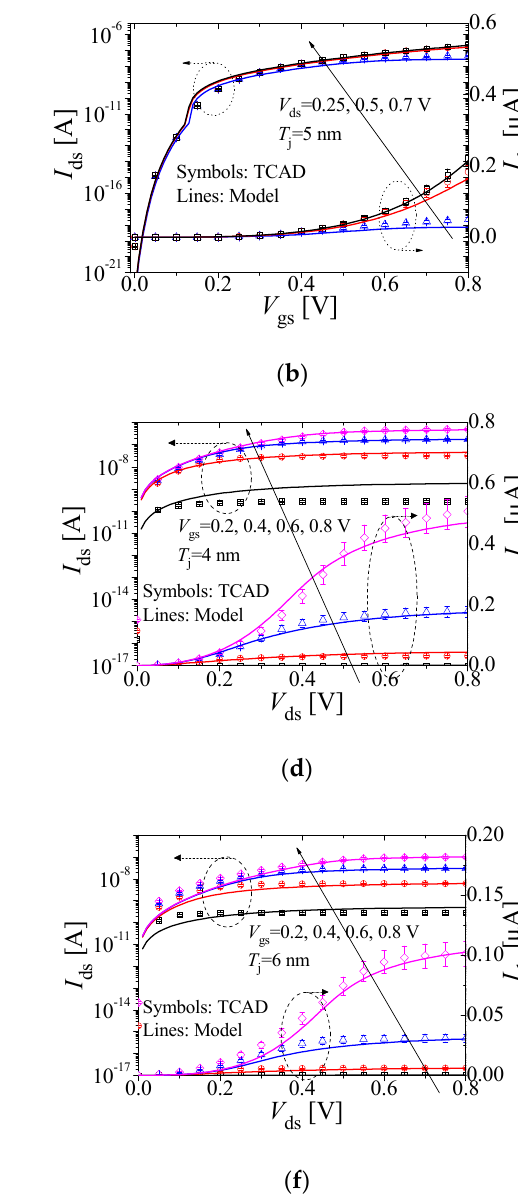
( b ) Figure 6. ( a , b ) Band diagram at V gs = 0.3 and 0.7 V, respectively, and both at V ds = 0.5 V, along the cutline of Figure 4. Black squares, green triangles, and red circles represent E c , E v , and q φ . respectively. Source-to-channel ( a ) and channel-to-channel ( b ) BTBT mechanisms are indicated with the help of arrows. 3. Results Figure 7a–c shows I ds – V gs characteristics of LTFET with T j = 4, 5, and 6 nm, respectively. Symbols and lines denote the simulation results of TCAD and the proposed model, respectively. Blue, red, and black colors denote V ds = 0.25, 0.5, and 0.7 V, respectively. A kink is observed in Figure 7a–c, at the transition point where the 1D model takes over the 2D model. This is observed because the 1D and 2D models are independent of each other and don’t produce the same and continuous G tun at the transition point. There is no noticeable change observed in the subthreshold behavior as T j is changed from 4 nm to 6 nm. However, the on-current ( I ON ) is observed to decrease as T j is increased. I ON at V gs = 0.8 V and V ds = 0.7 V is 0.48, 0.22, and 0.09 µA for T j = 4, 5, and 6 nm, respectively. This is because W t and G tun are inversely proportional, as can be observed from (13); the longer W t in T j = 5 and 6 nm results in lower G tun , and consequently, lower I ds . This effect is captured by the model reasonably well. This suggests that shorter T j is more desirable for getting higher I ON .